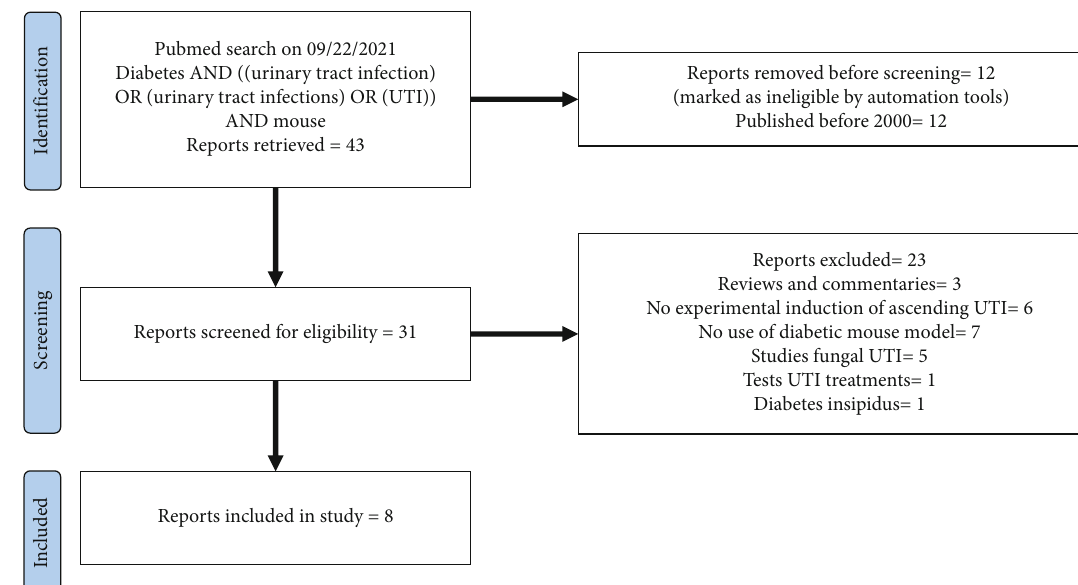
Figure 2: PRISMA fl ow diagram of describing inclusion and exclusion criteria for clinical